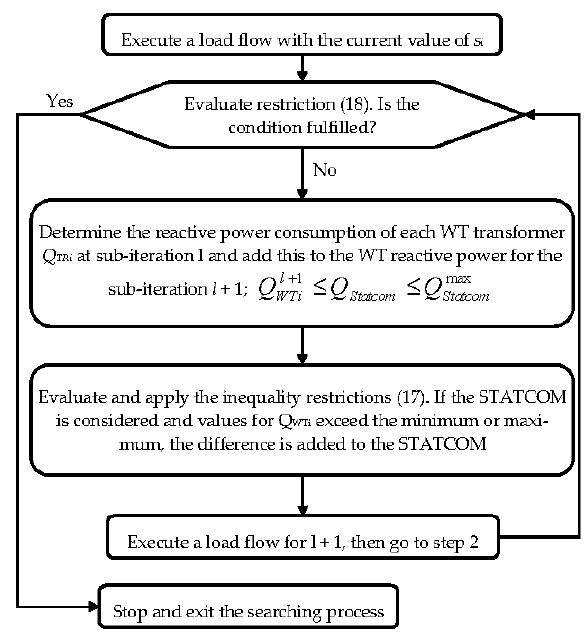
Figure 4. The flowchart of the suggested model.